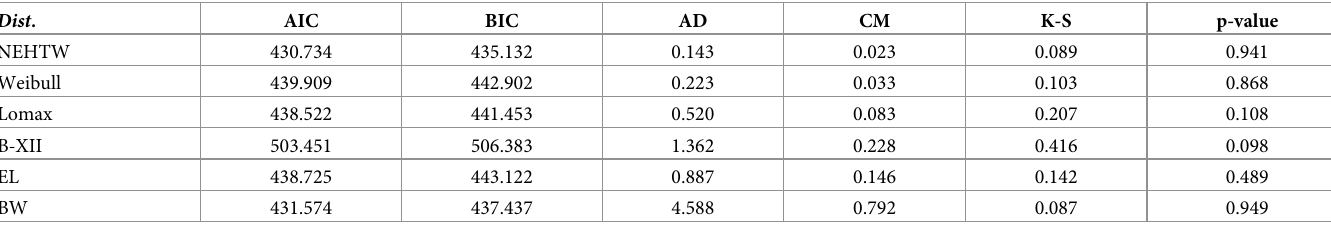
Table 12. Analytical measures of the NEHTW distribution and other competitors. Dist